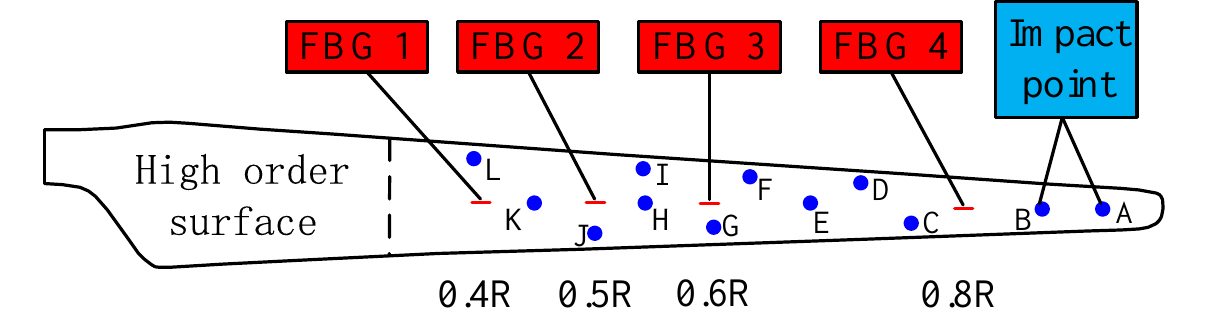
Figure 4. Location distribution of the FBGs and impact points. Sensors 2021 , 21 , x. https://doi.org/10.3390/xxxxx Table 3. The characteristics of the FBGs.